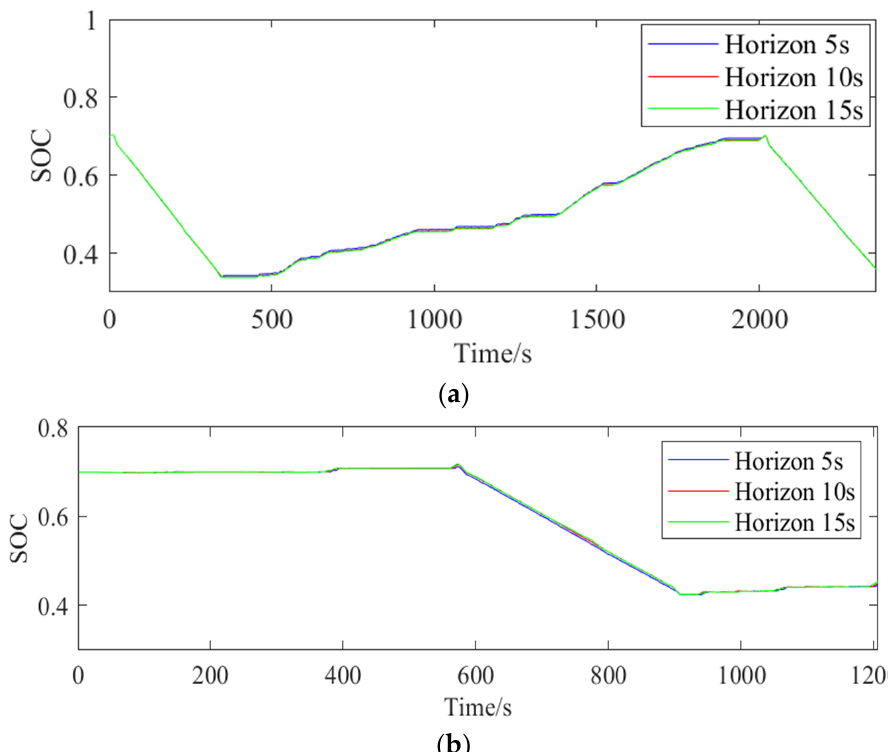
Figure 11. SOC profiles with different prediction horizon lengths. ( a ) SOC profiles with different predicted horizon lengths under driving cycle A. ( b ) SOC profiles with different predicted horizon lengths under driving cycle B. Table 2. Results of PMP-MPC with three prediction horizons in driving cycle A.